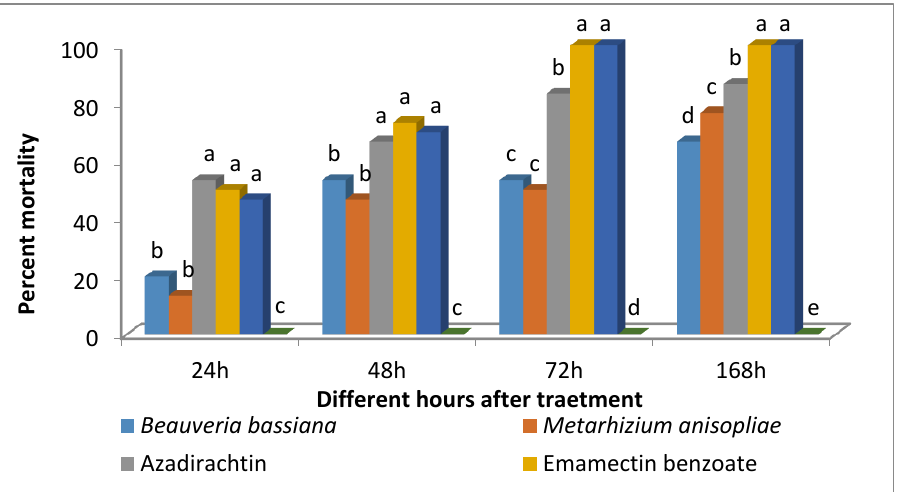
Figure 5. Efficacy of different biopesticides and insecticides against 3rd instar larvae of S. frugiperda. Bars marked with different letters differ significantly; p < 0.05, Duncan’s multiple range test .